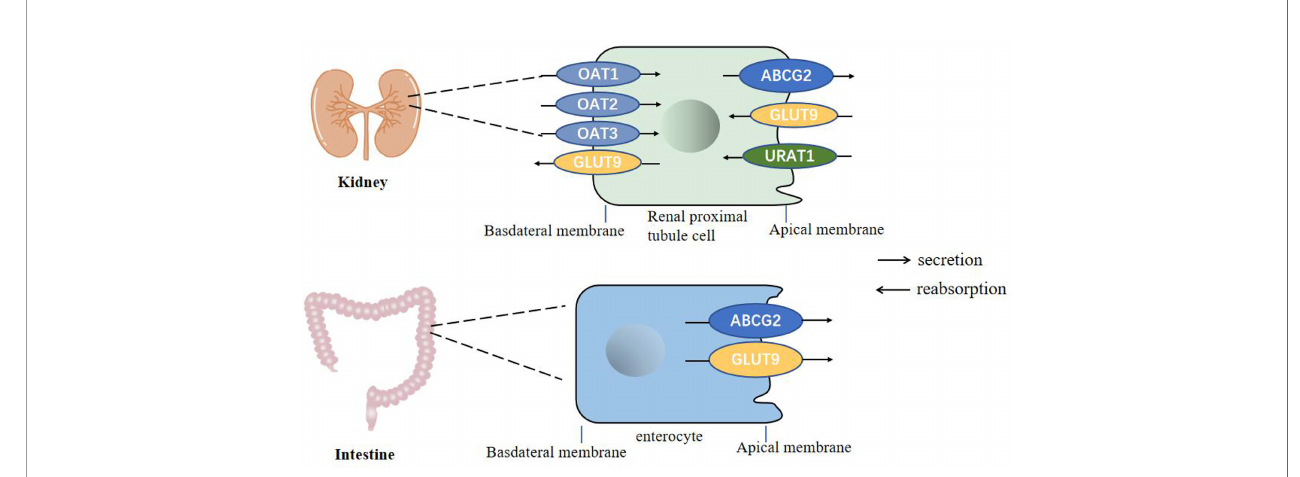
FIGURE 2 | Urate transporters in the kidneys and intestine in humans. GLUT9 and URAT1 on the proximal tubule cells mediate renal urate reabsorption, while GLUT9 on the enterocytes mediate urate excretion in the intestine. ABCG2 is involved in urate export in both the intestine and the kidney. OAT1, OAT2 and OAT3 are present on the basolateral membrane of renal proximal tubule cells and mediates urate